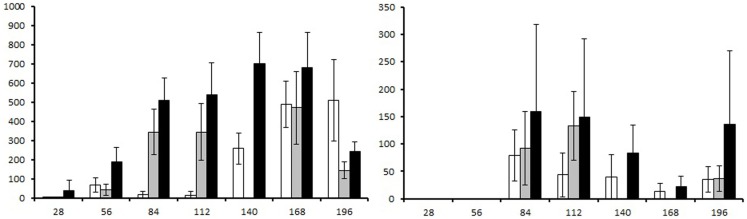
Fecal egg counts presented as eggs per gram (EPG) of feces generated over course of the study. Left graph: strongyle fecal egg count, right graph: ascarid fecal egg count. White columns: group 1 (ivermectin treatment on Day 56), gray columns: group 2 (ivermectin treatment on Day 112), and black columns: group 3 (no treatment control). Error bars represent 95% confidence intervals.